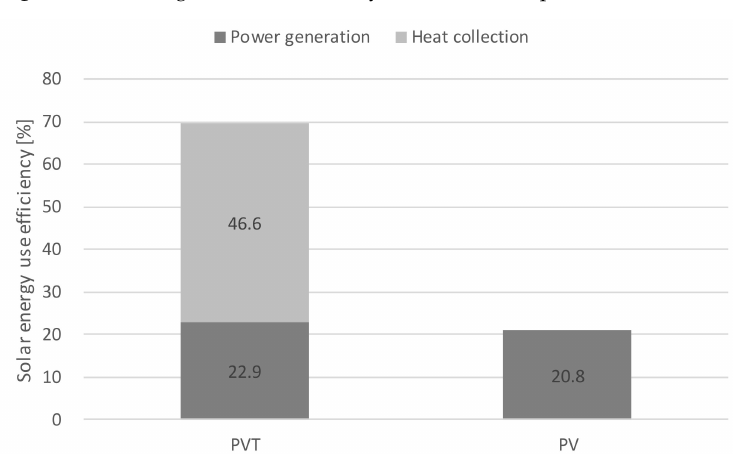
Figure 13. Solar energy utilization efficiency of PVT and PV